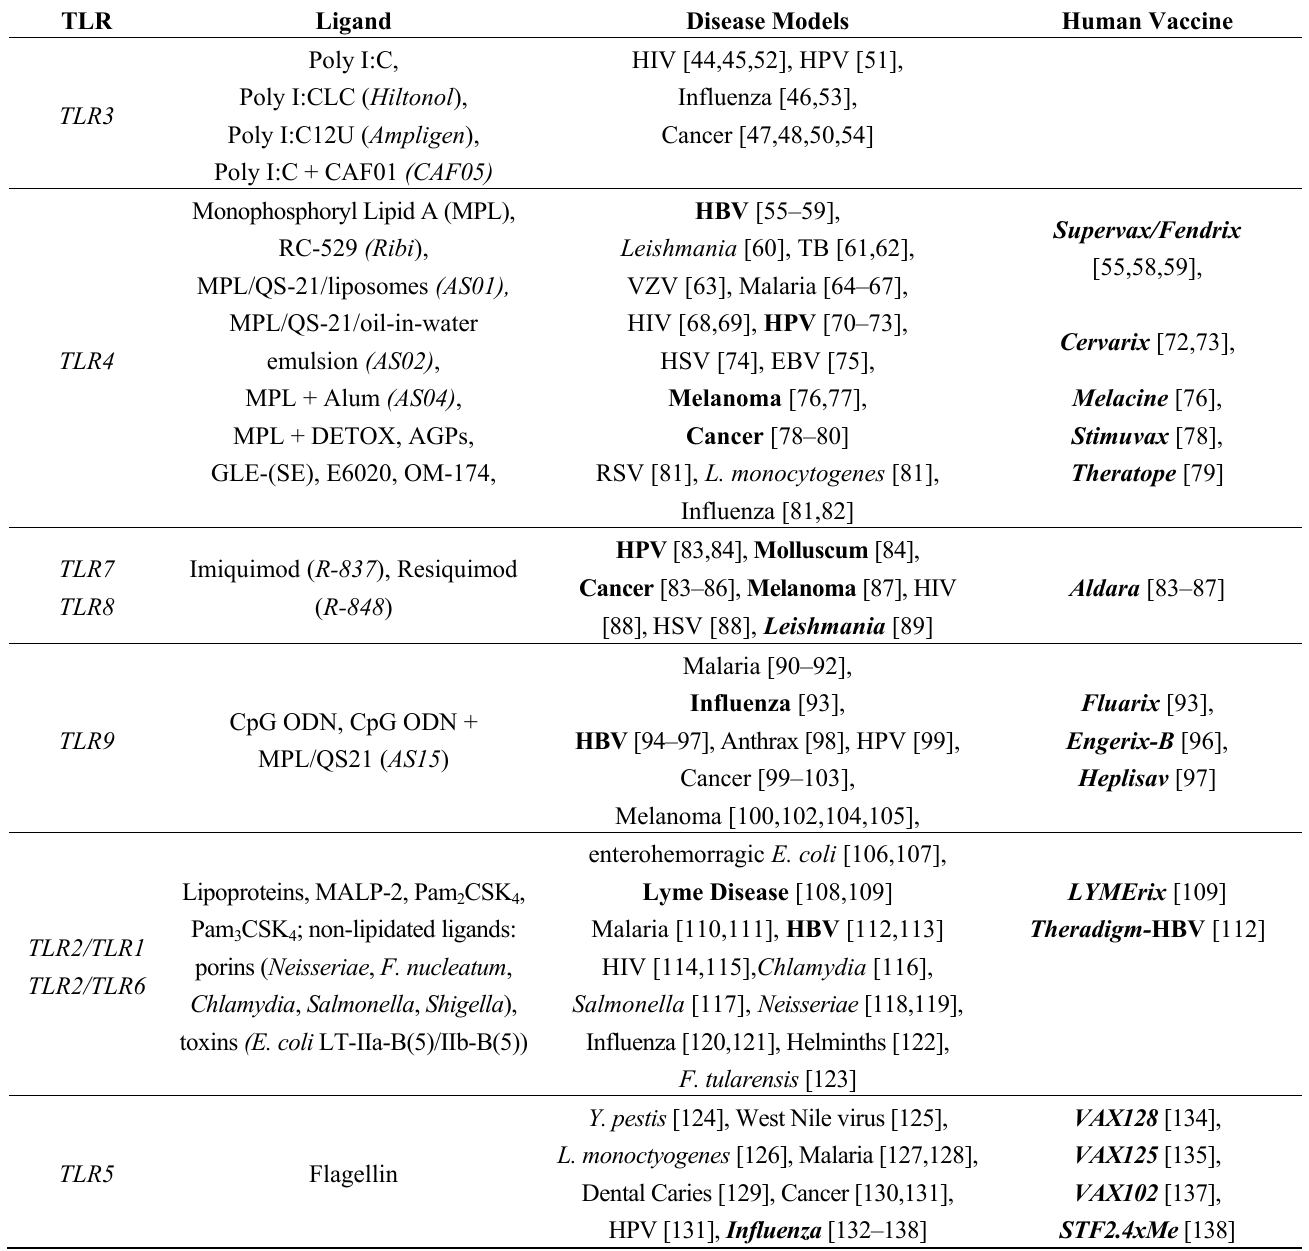
Table 1. Examples of TLR adjuvants, disease models tested in experimental and clinical trials, and human vaccines. Disease models and corresponding vaccines are shown in